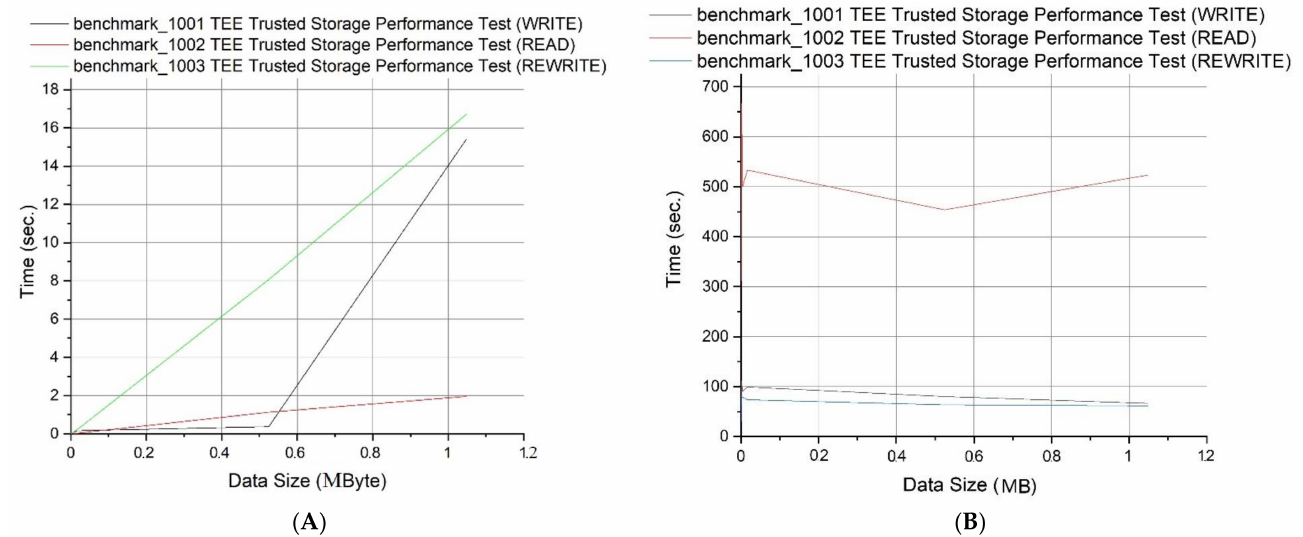
Figure 13. ( A ) WRITE, READ, REWRITE Tests—Data Size vs. Time and ( B ) Data Size vs.